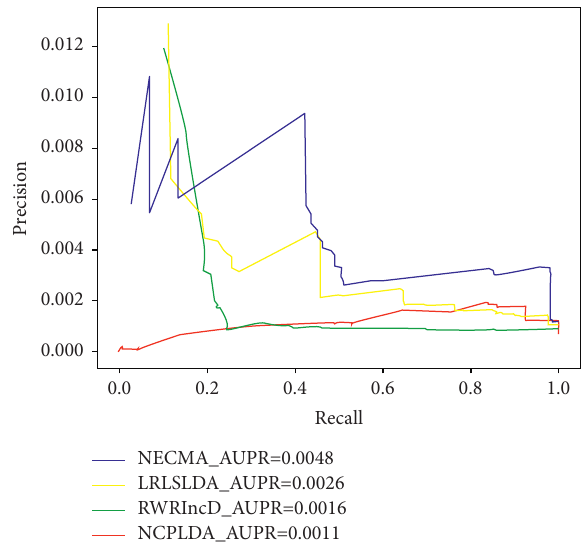
Figure 3: The AUPR values of the NECMA model and the other three algorithms on the ten-fold